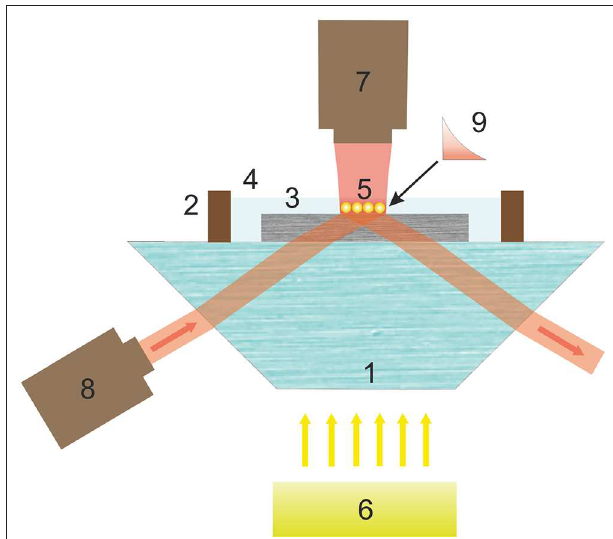
FIGURE 2 | Scheme of experimental setup for demonstrating controlled motion of gold nanoparticles by an evanescent wave in the near-surface layer of a birefringent section. Here, 1, prism; 2, cuvettes with tissue fluid 4; 3, birefringent section; 5, gold nanoparticles controlled by evanescent wave 9; 6, white-light illuminating source; 7, laser beam provided particle trapping; 8, laser radiation source producing an evanescent